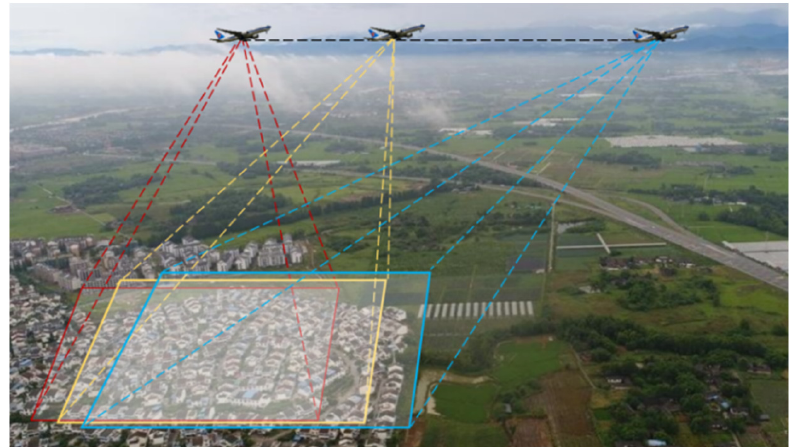
Figure 1. Aerial view to retrieve RS images.